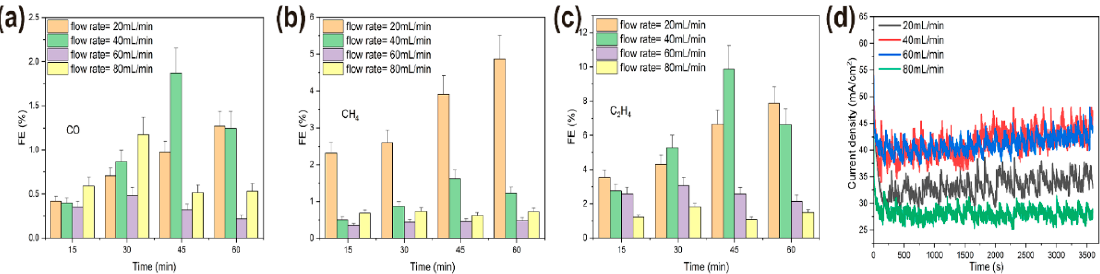
Figure 8. Electrocatalytic CO 2 reduction performances of operando synthesized coppers under 20, 40, 60, 80 mL/min flow rates. Faradic efficiencies of three main products ( a ) CO, ( b ) CH 4 , ( c ) C 2 H 4 . ( d ) Time-dependent total current density at − 2.1 V of different CO 2 flow rates.